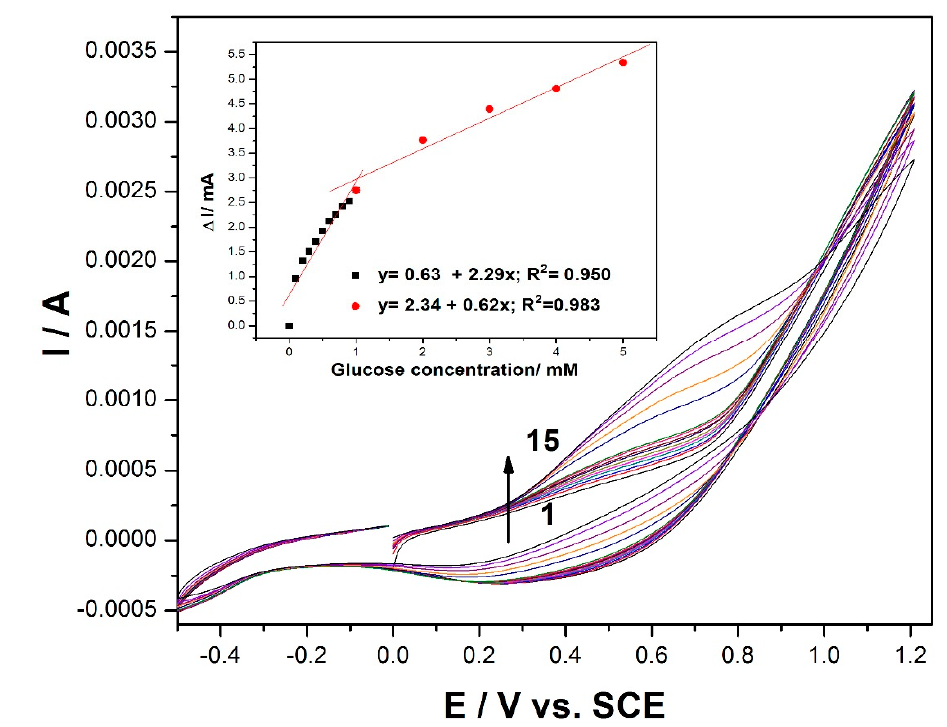
Figure 2. Cyclic voltammetry (CV) recordings at the MWCNT-CuBTC composite electrode in 0.1 M of NaOH supporting electrolyte (curve 1) and in the presence of various glucose concentrations: 0.1–0.9 mM (curves 2–10) and 1–5 mM (curves 11–15). The inset is the calibration plots of the current, recorded at +0.5 V/SCE versus the glucose concentration.